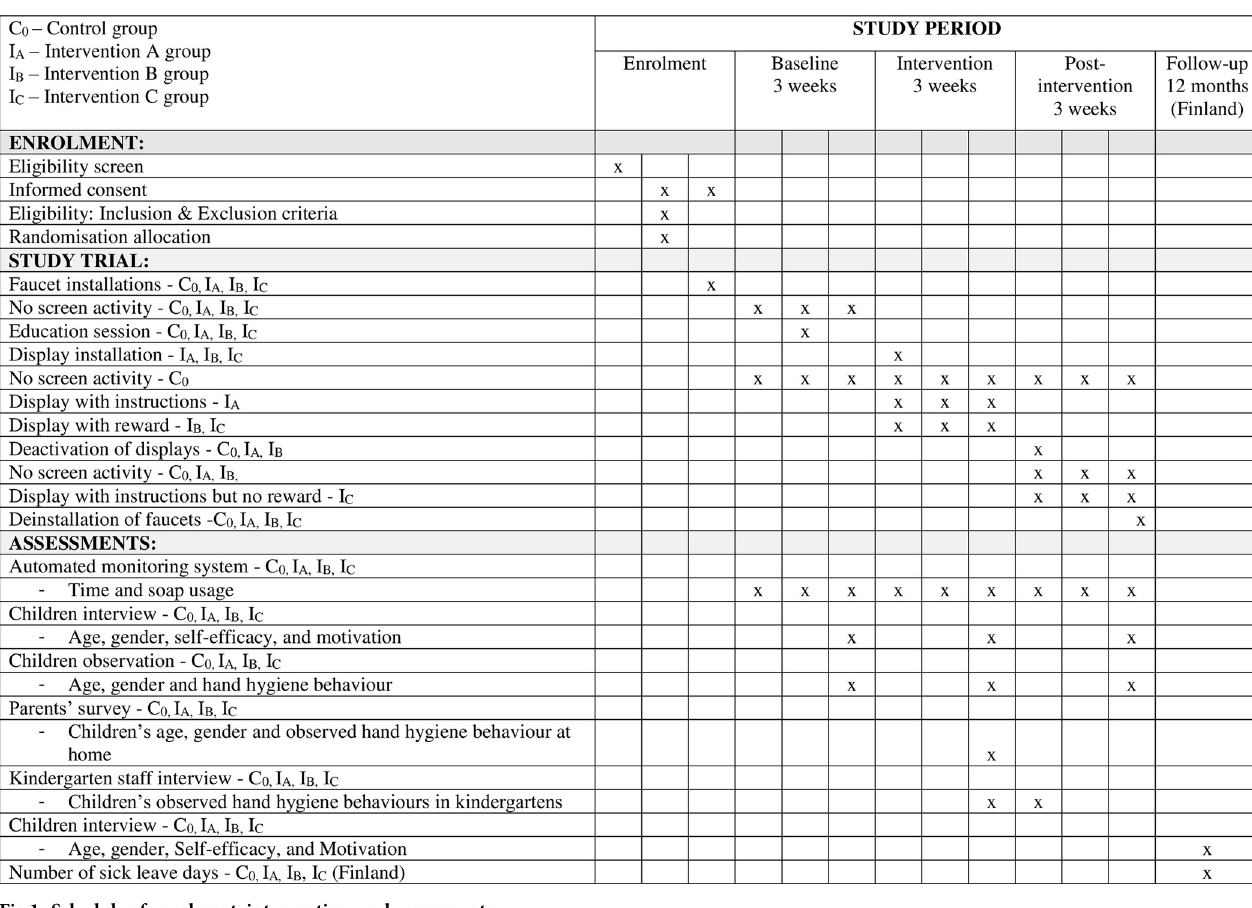
Fig 1. Schedule of enrolment, intervention, and assessments.